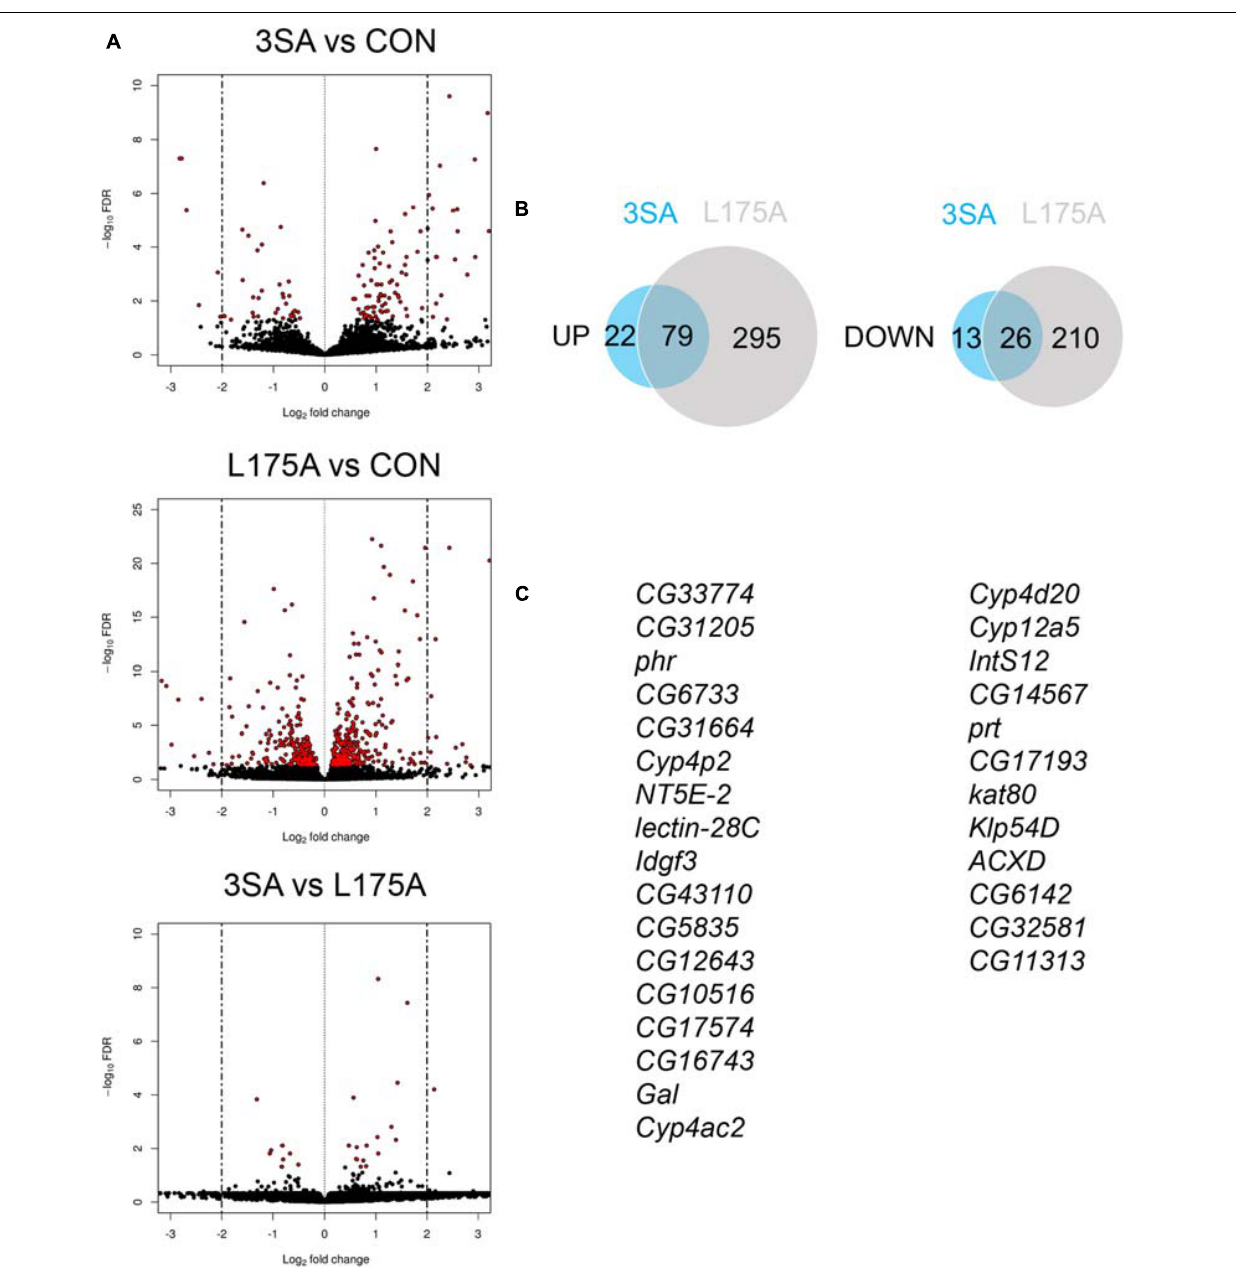
FIGURE 7 | Transcriptional changes resulting from expression of 3SA and L175A. (A) Genotypes were generated by crossing tubP-GAL80ts; OK107-GAL4 females to UAS-FLAG-3SA , UAS-FLAG-L175A or w(CS10) (indicate as CON) males. Expression was induced in the adult brain by raising the flies at 18 ◦ C and placing at 30 ◦ C 72 h prior to dissection. Volcano plots indicate differential expression between treatment groups. The horizontal axes indicate the Log2-fold change in expression and the vertical axis indicates the negative Log10 of the false discovery rate. Genes with significant differential expression (i.e., FDR < 0.05) are highlighted in red. Expression of L175A resulted in a higher number of differentially expressed genes than 3SA (2-sample test for equality of proportions (X-squared = 296.89, df = 1, p -value < 0.01). (B) Venn diagrams indicating the number of differentially regulated genes common to both control vs. L175A and control vs. 3SA data sets (C) List of genes significantly altered in expression by 3SA but not L175A. Only 29 genes were common to both data